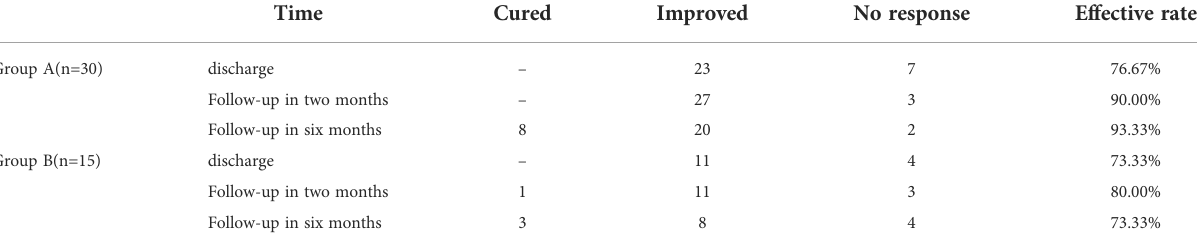
TABLE 2 Comparison of therapeutic ef fi cacy of the two